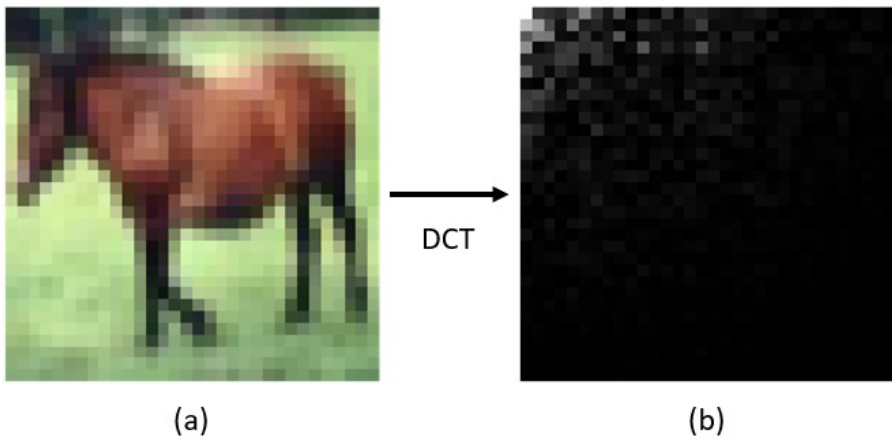
Figure 2. ( a ) Sample 32 × 32 image from CIFAR-10 [36]. DCT transforms the image pixel to the frequency domain. ( b ) 32 × 32 DCT coefficient matrix. White pixels represent the maximum DCT coefficient values, and black pixels represent the minimum DCT coefficient values close to zero.